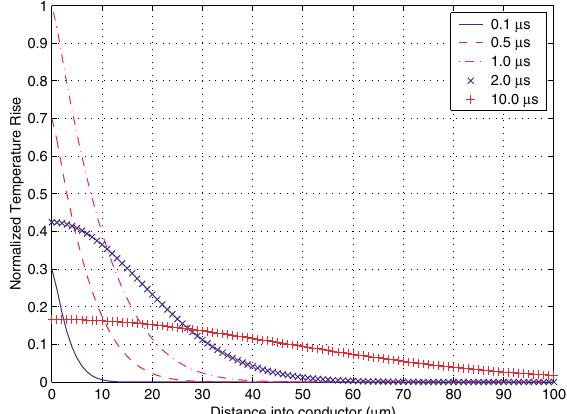
FIG. 10. (Color) The temperature rise at various times in the conductor normalized to the surface temperature at t (cid:2) 1 : 0 (cid:3) s , (cid:2) 1 : 0 (cid:3) s for a pulse length of t p